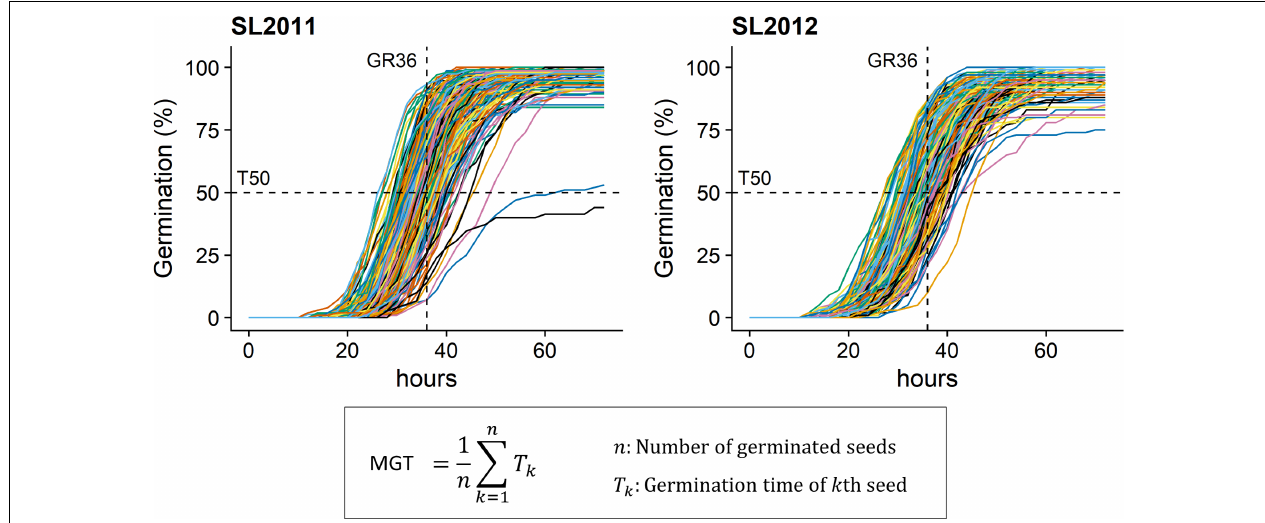
FIGURE 1 | Germination kinetics for seeds from 215 diverse winter oilseed rape lines produced in 2011 (SL2011) and 2012 (SL2012). T50, time necessary to reach 50% of germination; GR36, Germination rate within 36 h; MGT: mean germination